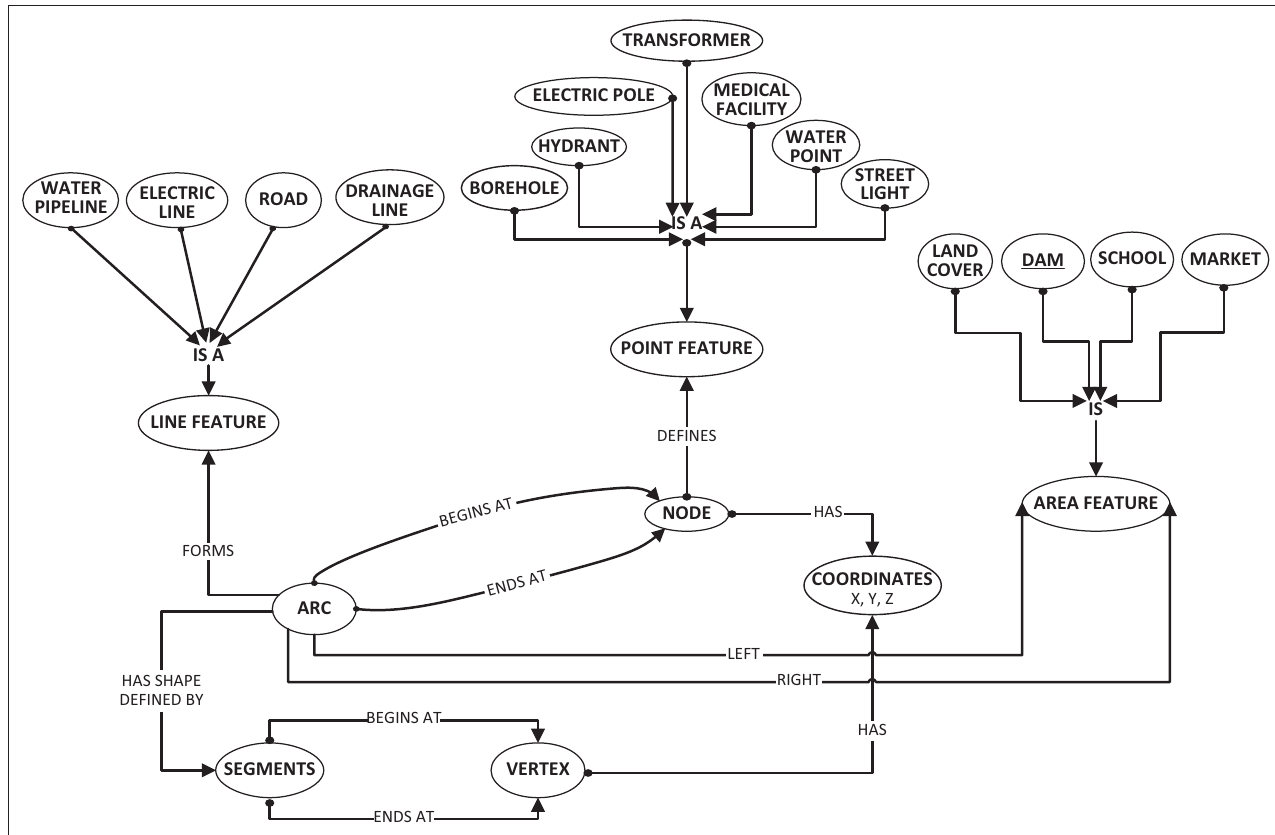
FIGURE 3: Spatial data model for urban critical infrastructure in the context of disaster